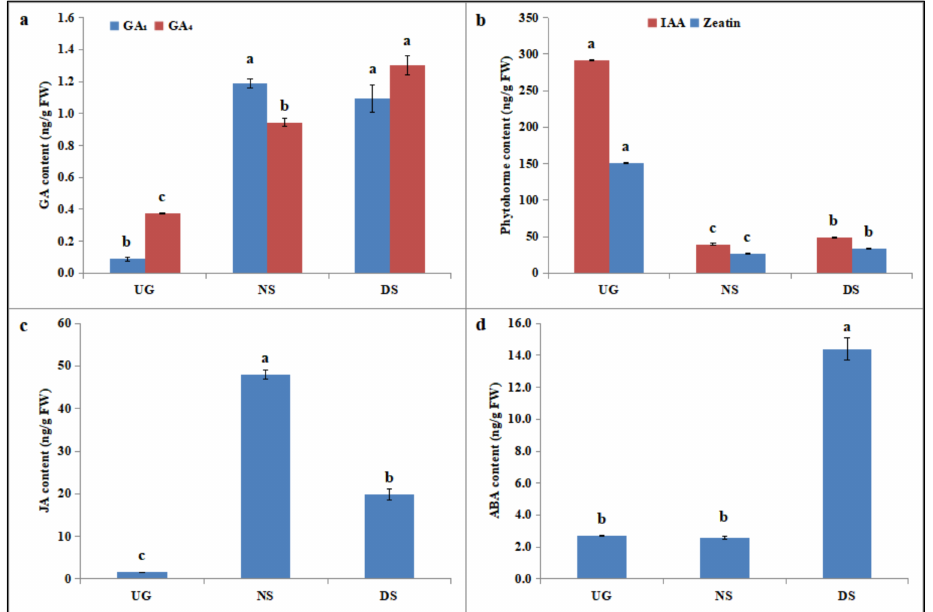
Figure 7. Effect of deep sowing on phytohormone changes in maize embryos. Means with standard deviations not followed by the same lower-case letter significantly differ by Tukey test at a 5% level of significance. ( a ) Changes in gibberellin 1 and 4 levels in maize embryos; ( b ) changes in indole acetic-acid and zeatin levels in maize embryos; ( c , d ) changes in jasmonic-acid and abscisic-acid levels in maize embryos,